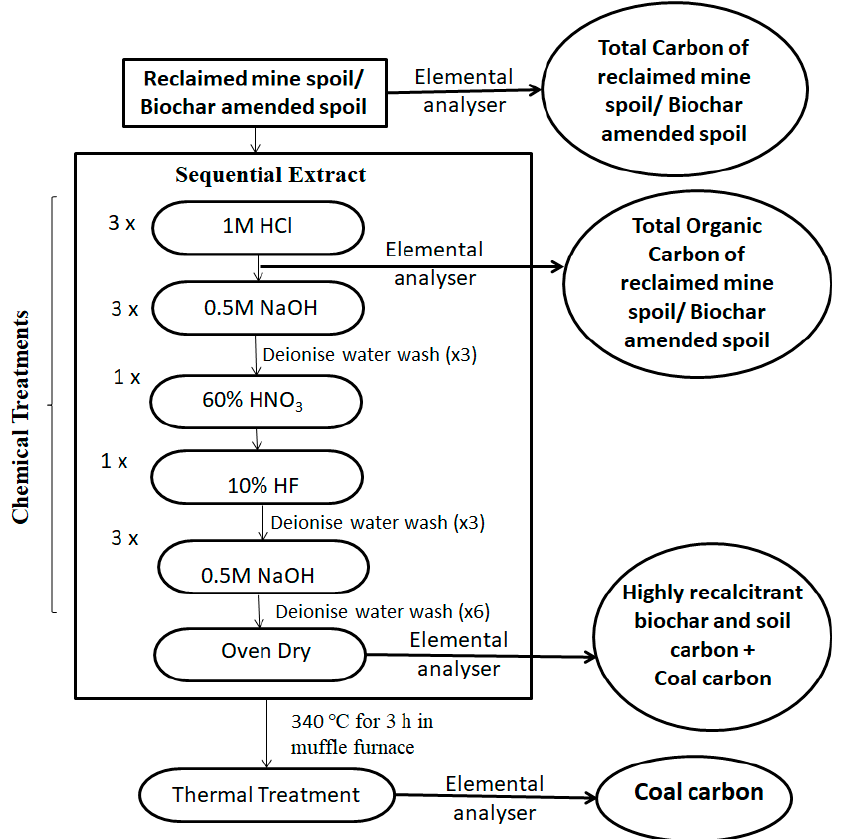
Figure 3. Sequential methods for the determination of total carbon, inorganic carbon and biogenic carbon pools in RMS, BC 30 , BC 60 and RF (n x indicated the number of times the step was repeated).